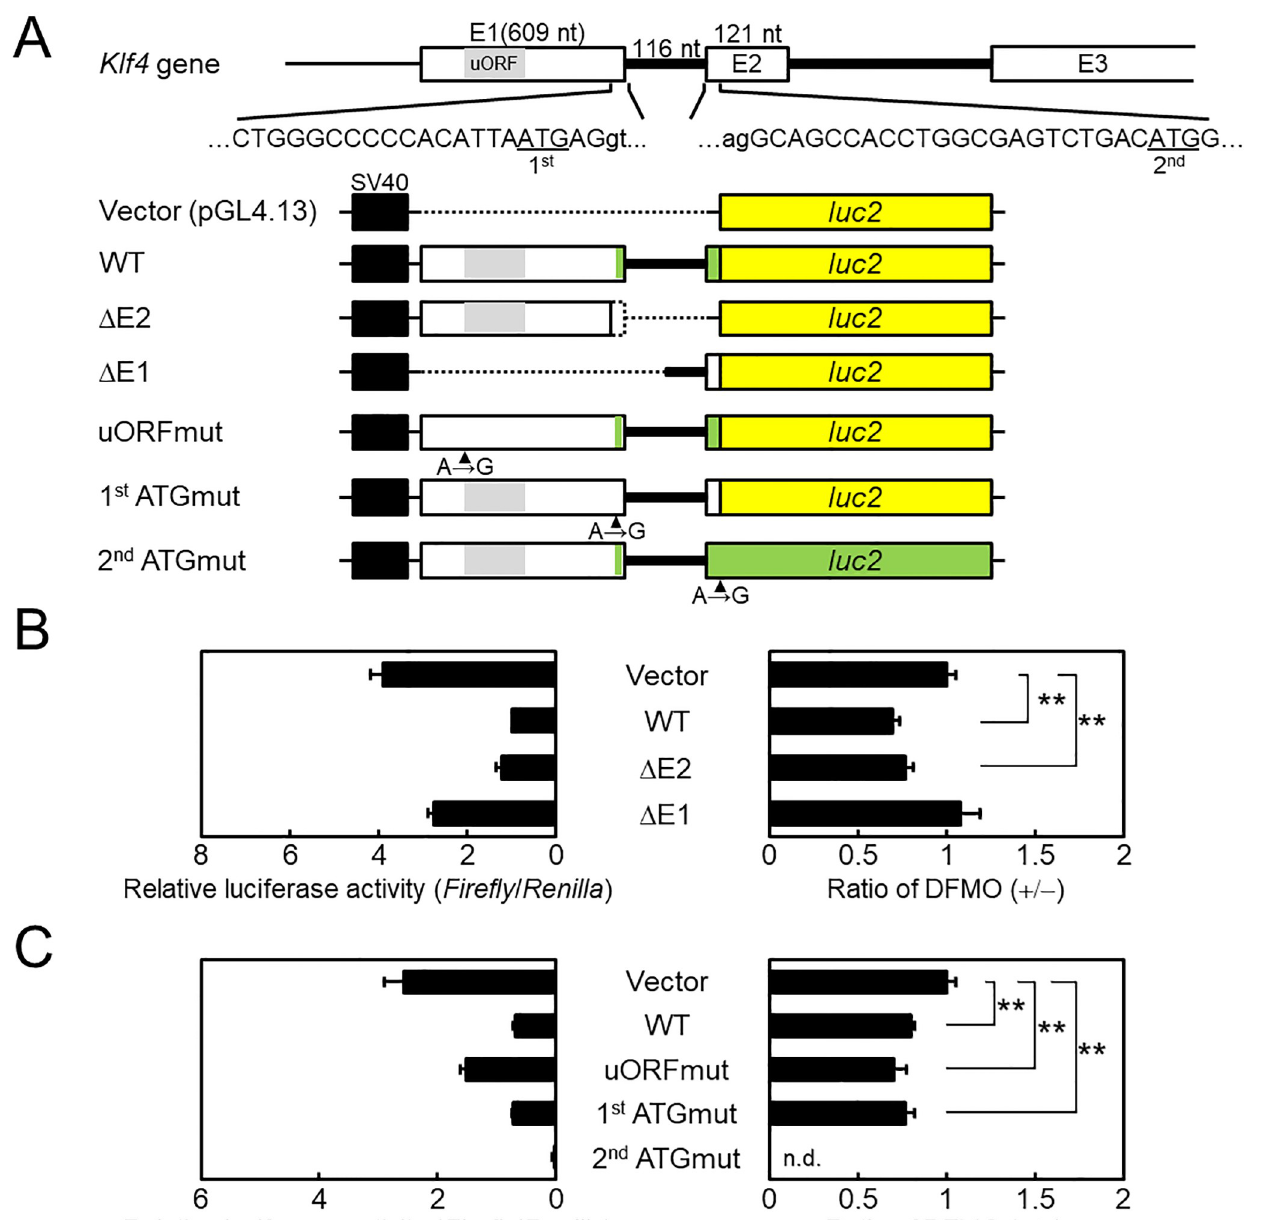
Fig 5. Effect of polyamines on luciferase activity from normal and modified Klf4-luc2 reporter plasmids in NIH3T3 cells. (A) Schematic illustration of mouse Klf4 (E1-E3) and various Klf4-luc2 reporter plasmids are shown. Nucleotide sequences for exons and introns are represented as uppercase and lowercase, respectively. The two initiation codons (ATG) on Klf4 are underlined as 1 st and 2 nd . The dotted line on Klf4-luc2 reporter plasmids means that the region was deleted from WT plasmid. The site of mutated initiation codon, by site-directed mutagenesis, is indicated by an arrowhead (A ! G). The green box in the plasmid illustration means the case of translation from 1 st initiation codon on E1. The yellow box shows luc2 ORF. (B) and (C); NIH3T3 cells co- transfected with the reporter plasmids and pGL4.75[ hRluc /CMV] in the absence or presence of 5 mM DFMO, respectively. The graph on the left shows relative luciferase activities measured as the ratio of firefly and Renilla luciferase activity. The graph on the right shows data calculated as the ratio of relative luciferase activity of DFMO (+/ − ). The values of vector are shown as 1. Mean ± s.d. is shown, n = 3 replicates. �� p < 0.01 compared with vector. n.d., not